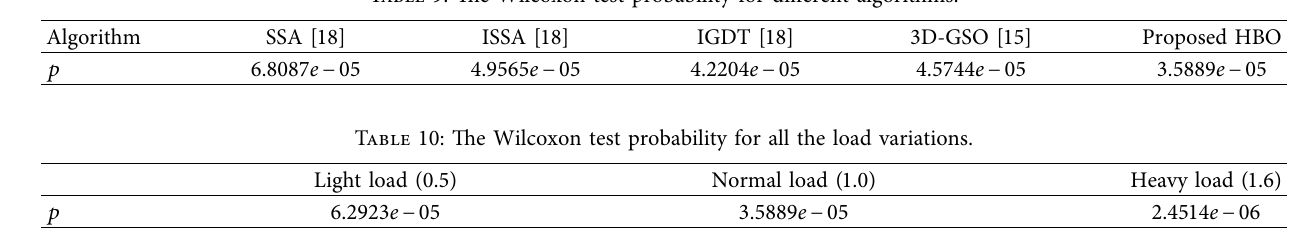
Table 11: Results of the Friedman test for all the load variations. Light load